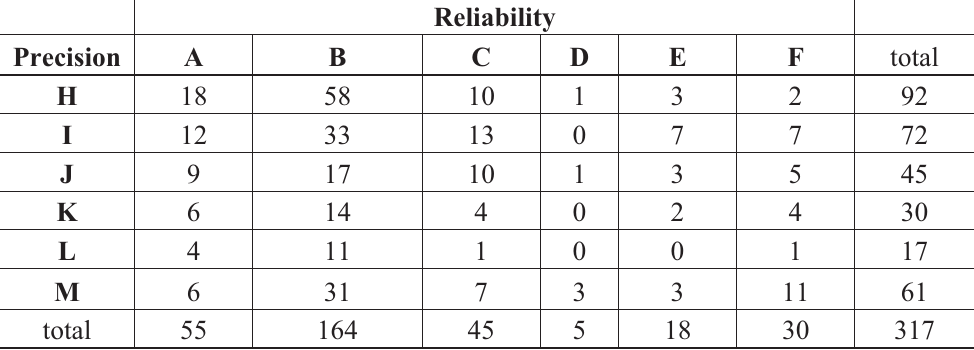
Table 2. Number of occurrence records of the white-nosed coati ( Nasua narica ) in Arizona Table 1). Sample sizes in this table may not match the sample sizes used in the